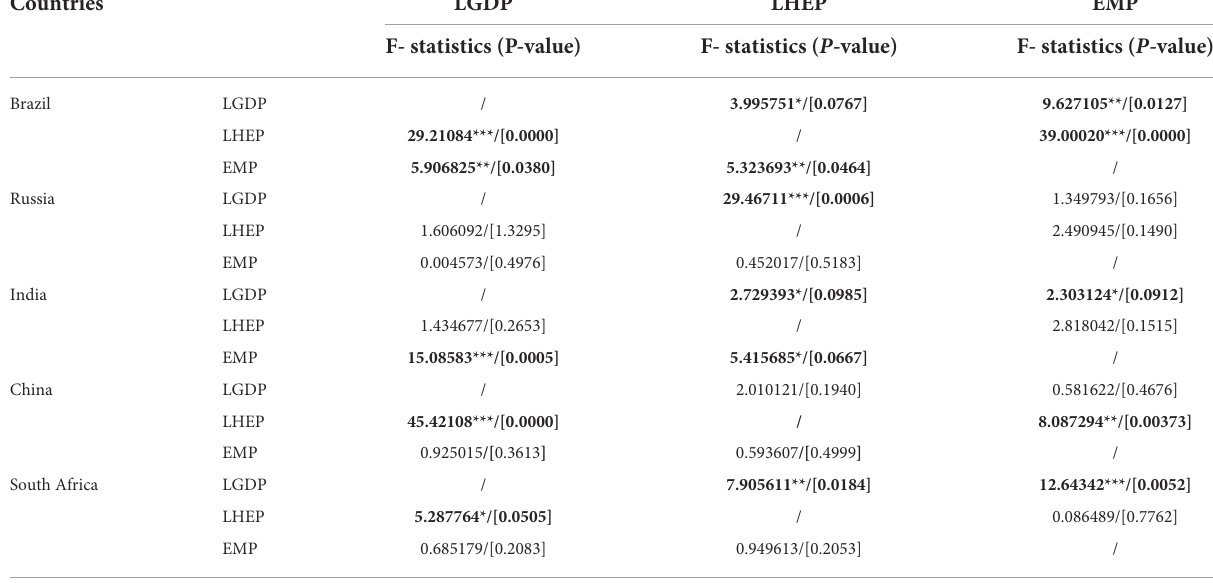
TABLE 8 Causality test.